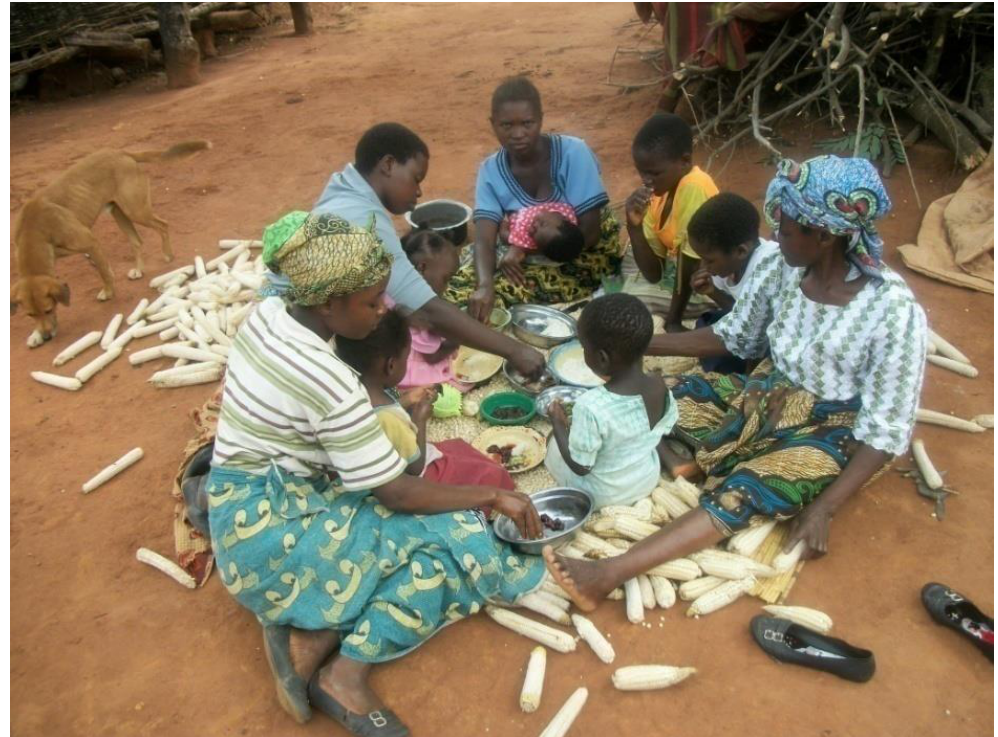
Picture 5.2: Women and girls eating. Is the food enough to feed the